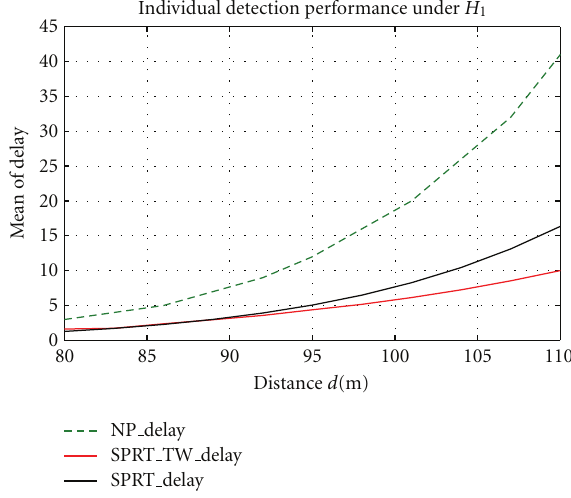
Figure 5: Delay performance